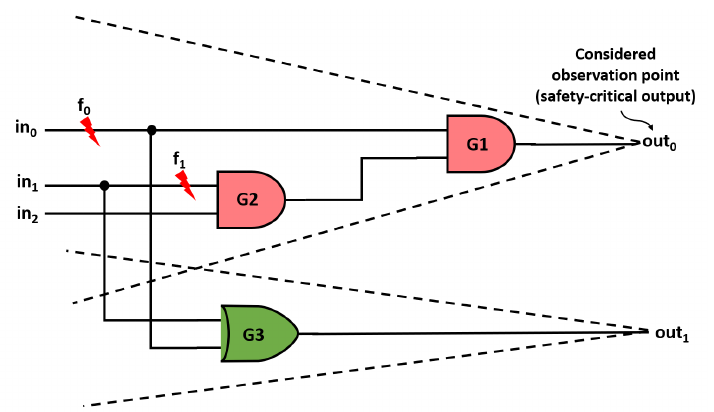
Figure 3. Unactivatable and unpropagatable analysis